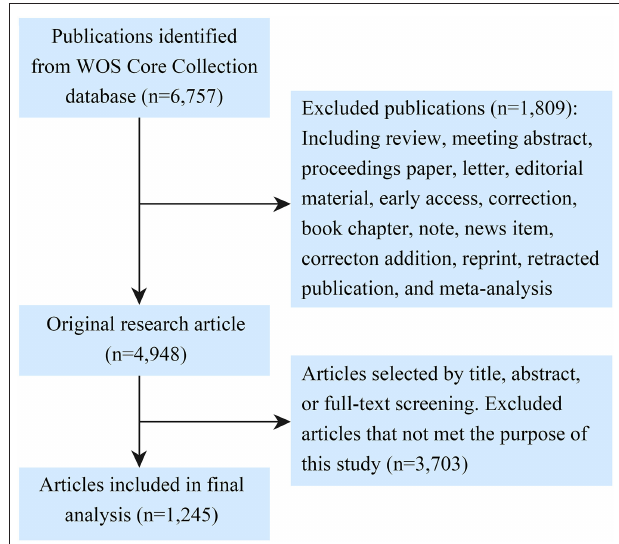
FIGURE 1 | Flowchart of the identification of relevant